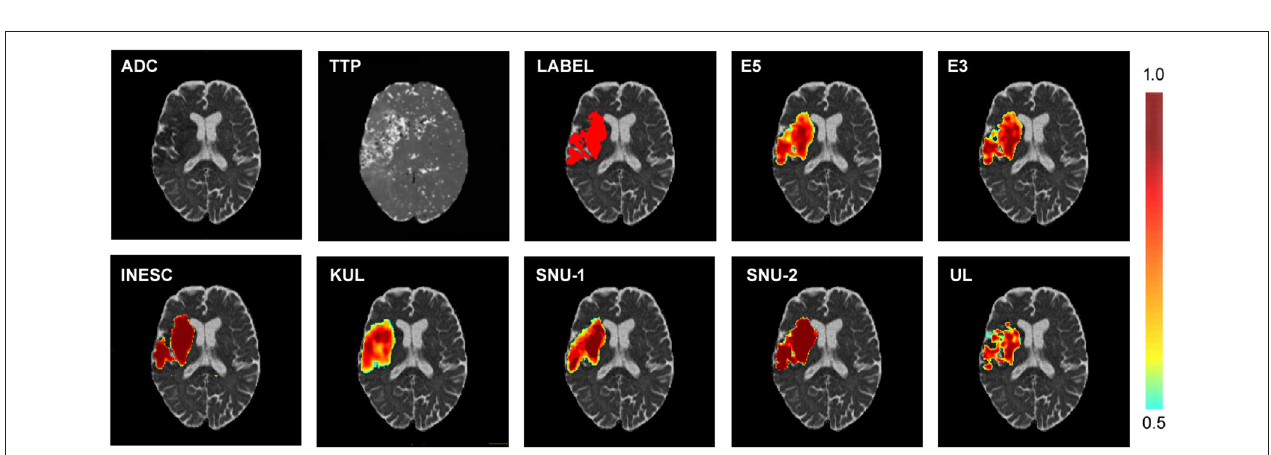
FIGURE 8 | Example of different softmax maps of one patient. Top row: Diffusion (ADC) and perfusion (TTP) scan and the corresponding manual lesion annotation (LABEL) and the softmax maps of the ensembles of the top five (E5) and top three (E3) ranked teams. Bottom row: Softmax maps of the top five ranking teams. Both shape and certainty (see color bar) of the predicted lesion vary between the different participants.